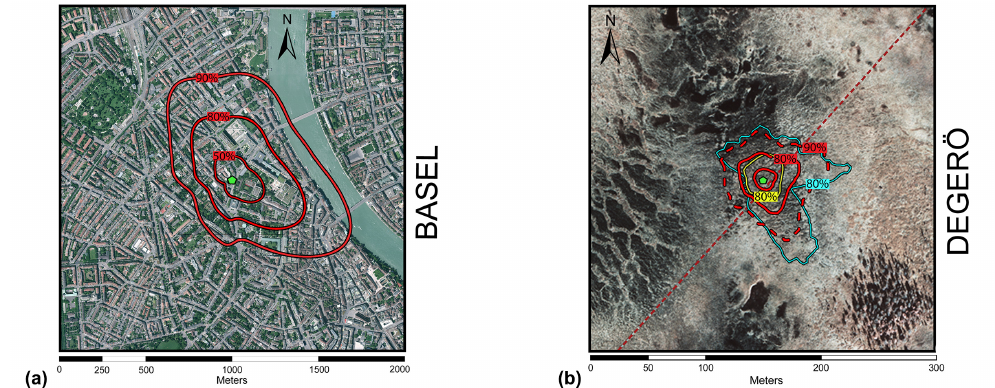
Figure 5. Aerial RGB and IR photographs with red contours containing 50, 80 and 90% of the flux during the campaign in Basel (a) and Degerö (b) . The yellow and blue 80% contours at Degerö stand for unstable and stable conditions, respectively. The light-green pentagons indicate the location of the flux towers.